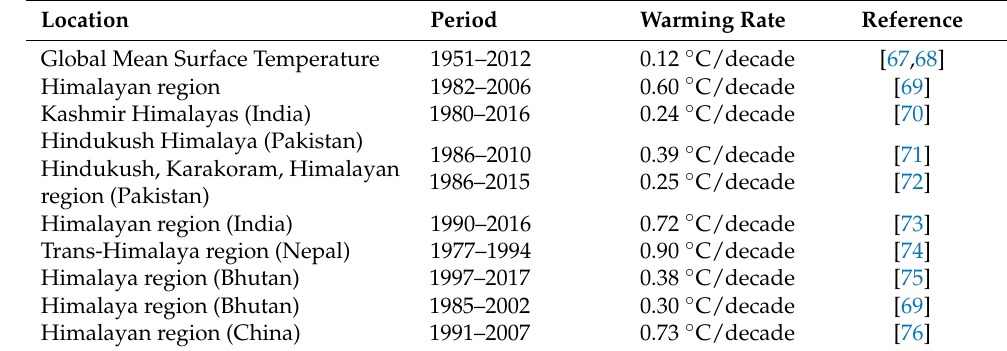
Table 2. Climate warming rates from the selected sources in the Himalayan region.